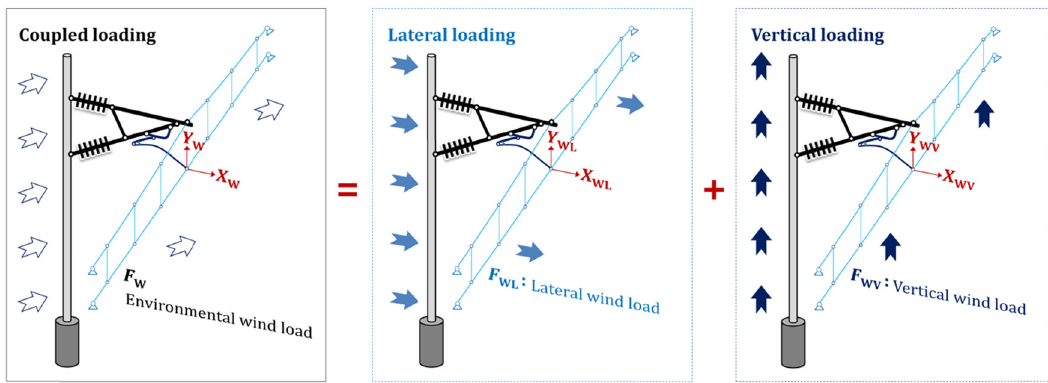
Figure 8: Wind loading decoupling rule on suspension